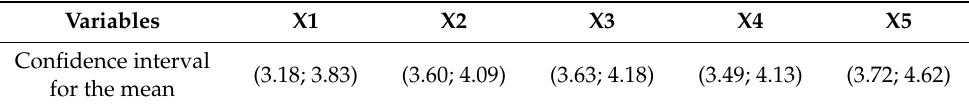
Table 5. Confidence interval for the